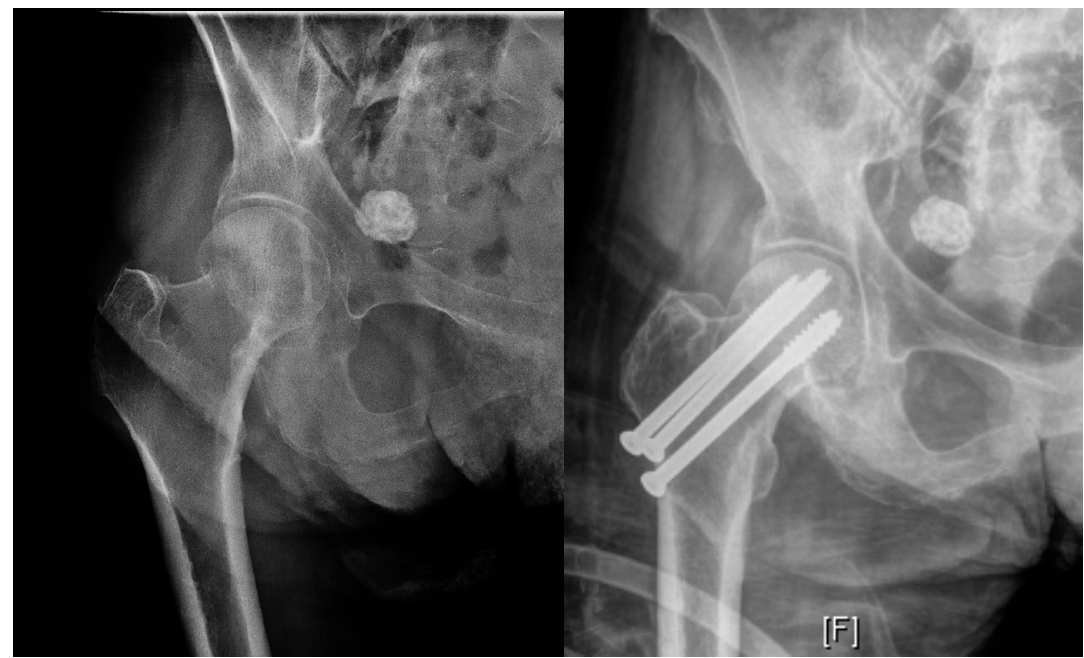
Figure 2. Example radiographs demonstrating internal fixation for Garden I (Left: Preoperative, right: